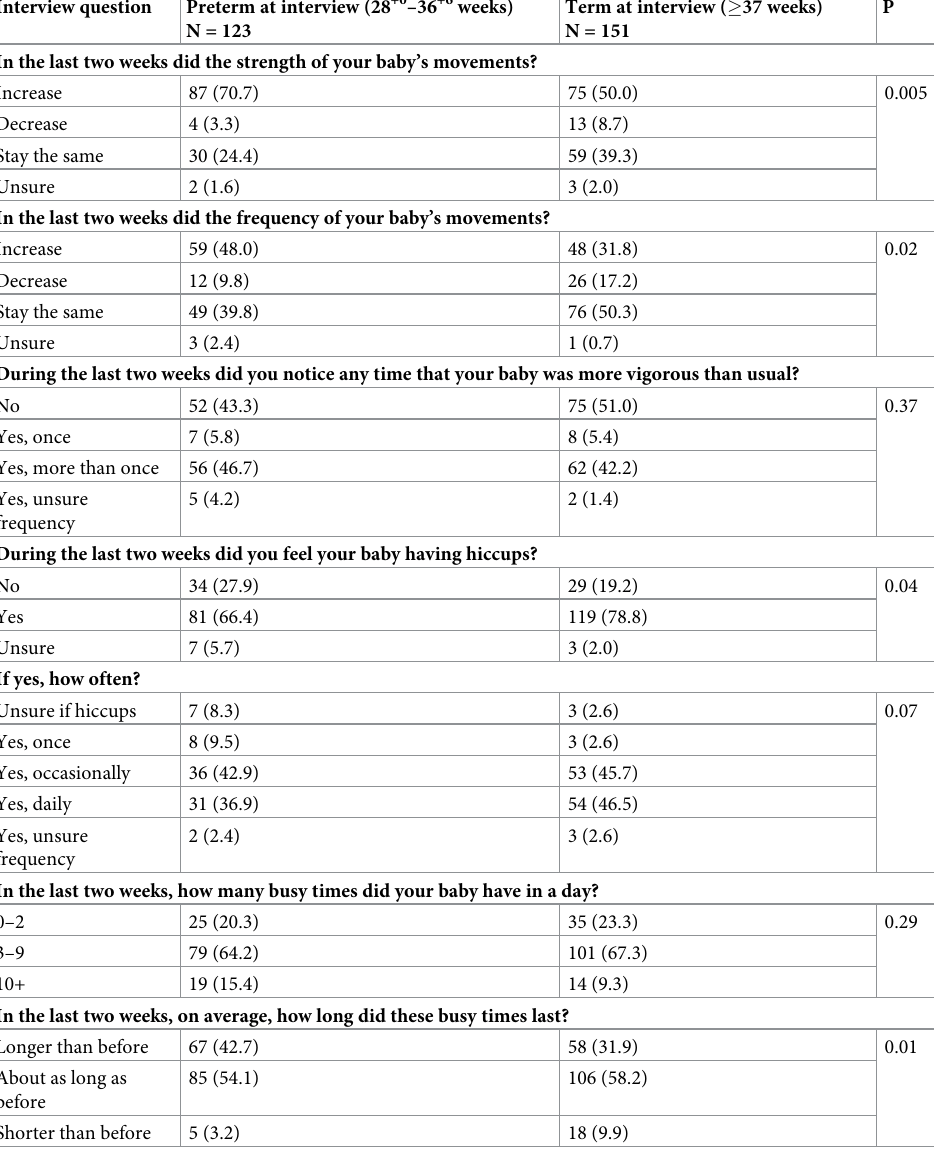
Table 6. Fetal movement strength, frequency, hiccups and busy times by gestation at interview. Interview question Preterm at interview (28 +0 –36 +6 weeks) N = 123